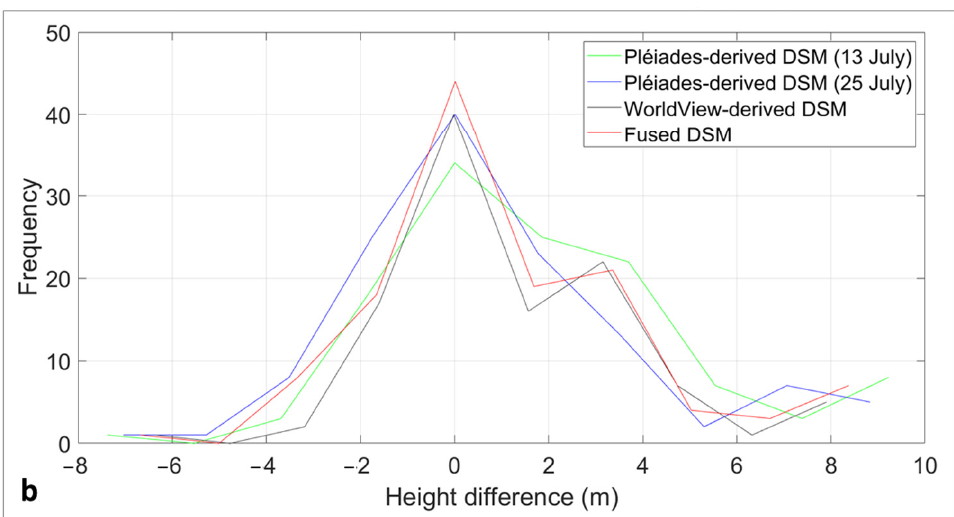
Figure 4. ( a ) Spatial distribution of the GPS Ground Control Points (GCPs, red symbols) used to validate the fused Digital Surface Model (DSM); ( b ) Histogram of the residuals of the three input DSMs and the fused one, all peaking at zero, proving their correct co-registration.